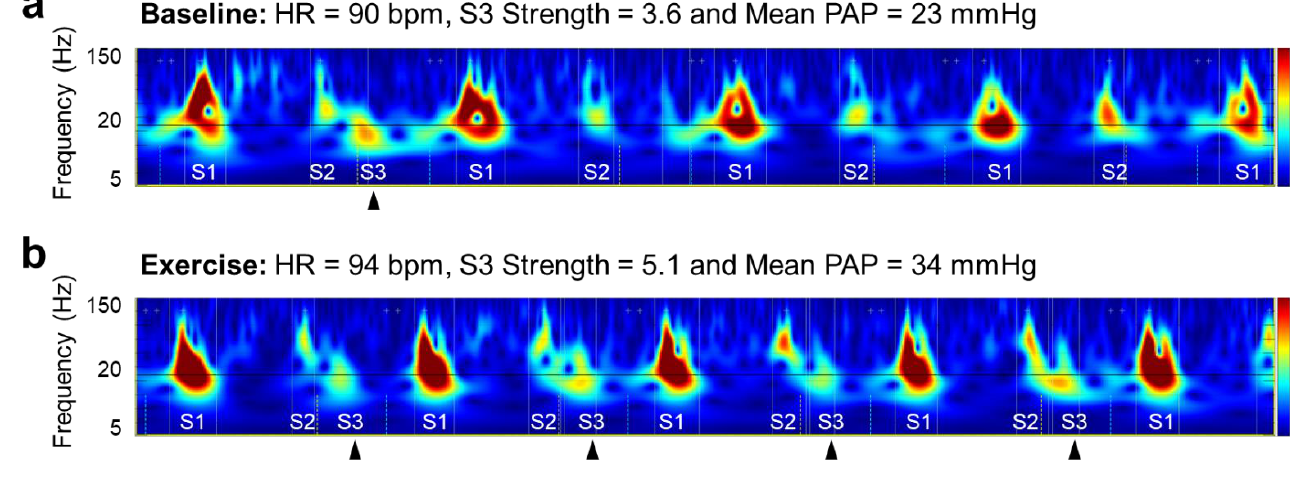
Figure 2. Visual description of change in S3 and corresponding S3 Strength in relation to hemody- namic alternation from baseline ( a ) to exercise ( b ). HR heart rate, PAP pulmonary artery pressure, S1 first heart sound, S2 second heart sound, S3 third heart sound.